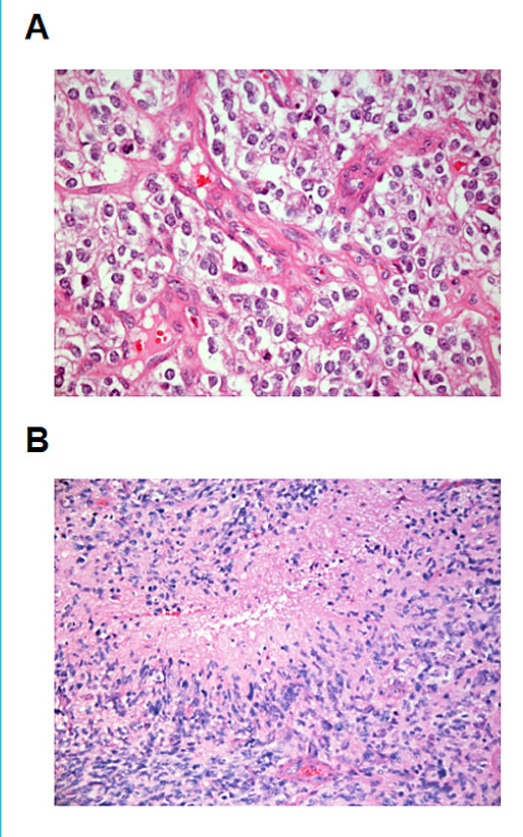
Figure 2: Exemples of the histopathological features of gliomas. Haematoxylin and eosin staining of tumour tissue speci- mens. A. Anaplastic oligodendrogioma with typical cytoplasmatic halos (“fried eggs”) which are the result of a fixation artifact (mag- nification 400×). B. Glioblastoma with pseudopalisading necrosis (magnification 200×). Images courtesy of G. Reifenberger, MD, In- stitute of Neuropathology,